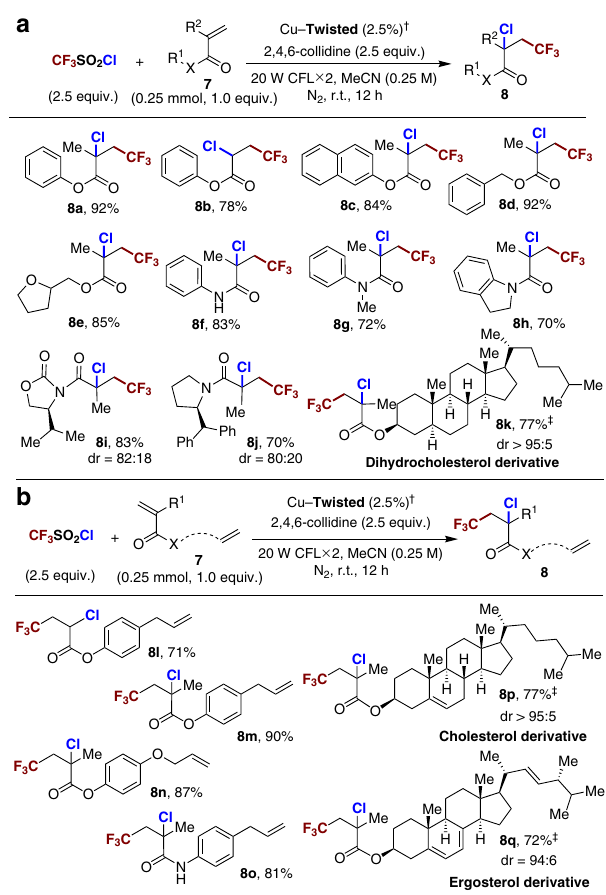
Fig. 8 Tri fl uoromethylation-chloration difunctionalisation of ole fi ns. a Substrate scope of α , β -unsaturated esters and amides. b